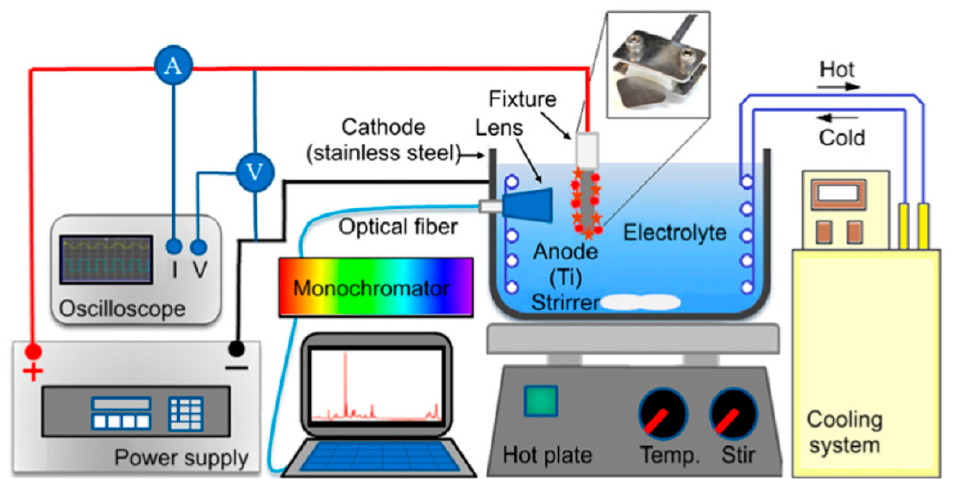
Figure 1. Schematic diagram of the micro-arc oxidation (MAO) process [17]. Reprinted with permission from reference [17] 2017 Elsevier.